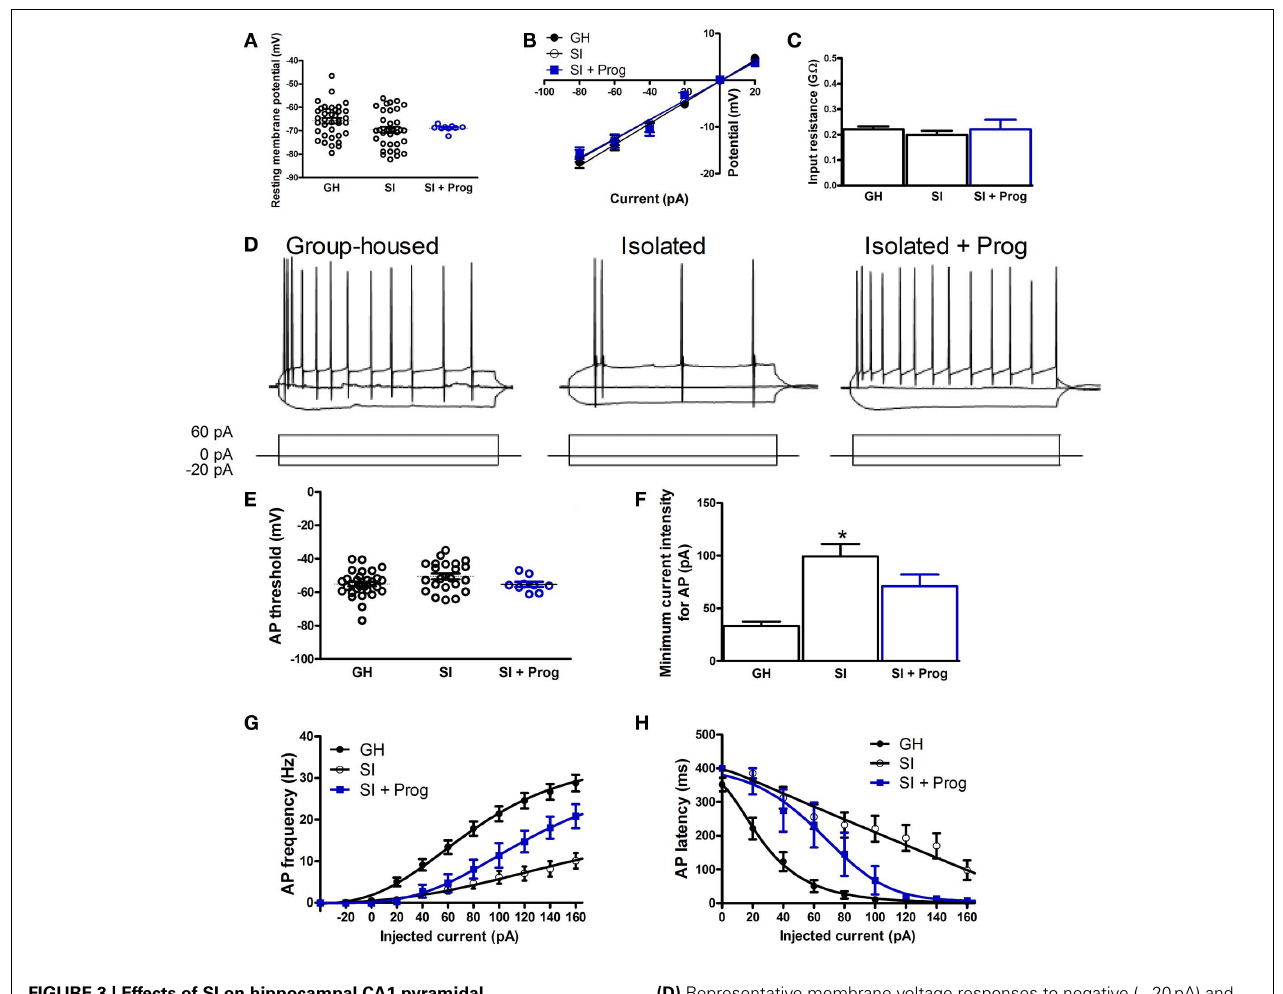
FIGURE 3 | Effects of SI on hippocampal CA1 pyramidal neuron excitability and their reversal by progesterone treatment. (A–C) Lack of effect of SI or progesterone (Prog) treatment on membrane resting potential (A) the membrane potential–current relation (B) or membrane input resistance (C) determined by whole-cell patch-clamp analysis in the current-clamp mode. SI mice were treated daily with progesterone or vehicle before analysis. Data are for 37, 25, and 9 neurons in (A) and for 37, 25, and 9 neurons in (B,C) for GH, SI, and progesterone-treated SI mice, respectively; those in (B,C) are means ± SEM.